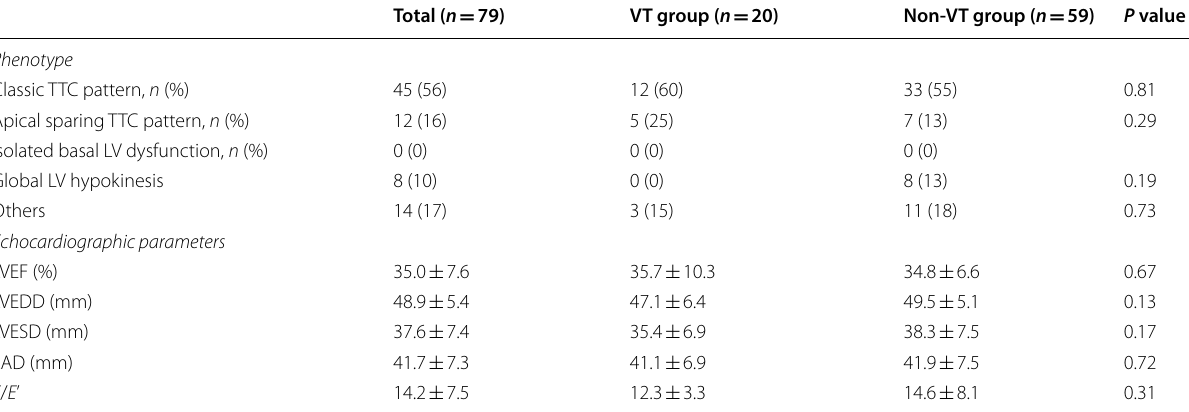
Values are mean SD or number (%); TTE transthoracic echocardiography; VT ventricular tachycardia; TTC Takotsubo cardiomyopathy; LVEF left ventricular ejection ± fraction; LVEDD left ventricular end-diastolic diameter; LVESD left ventricular end-systolic diameter; LAD left atrial diameter; E/E’ early diastolic mitral inflow